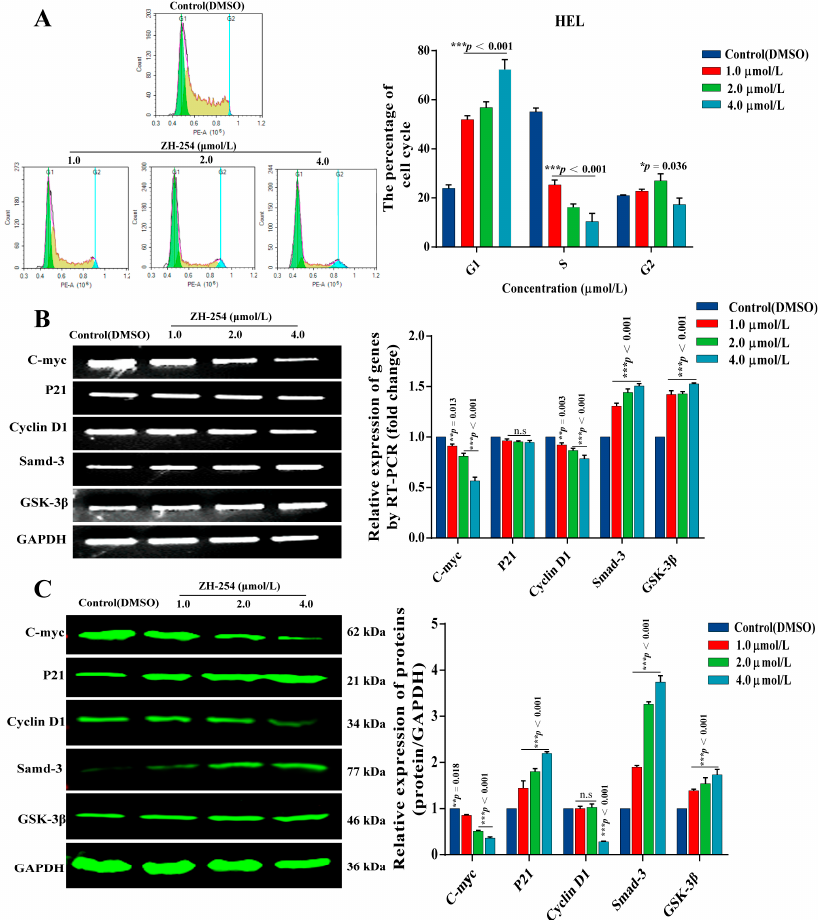
Figure 5. Effect of ZH-254 on HEL cell cycle, which is involved in expressing G1-cycle-related pro- teins. ( A ) ZH-254 on HEL cell cycle by flow cytometry. Statistical analysis of the proportion of cells in different cell cycle phases in different periods. ( B , C ) Regulation of ZH-254 on G1-phase-related gene and protein expression was assessed by RT-PCR and Western blotting. Quantitative analysis with Image J software (V1.8.0.112, NIH, Bethesda, MD USA). * p < 0.05, *** p < 0.001.